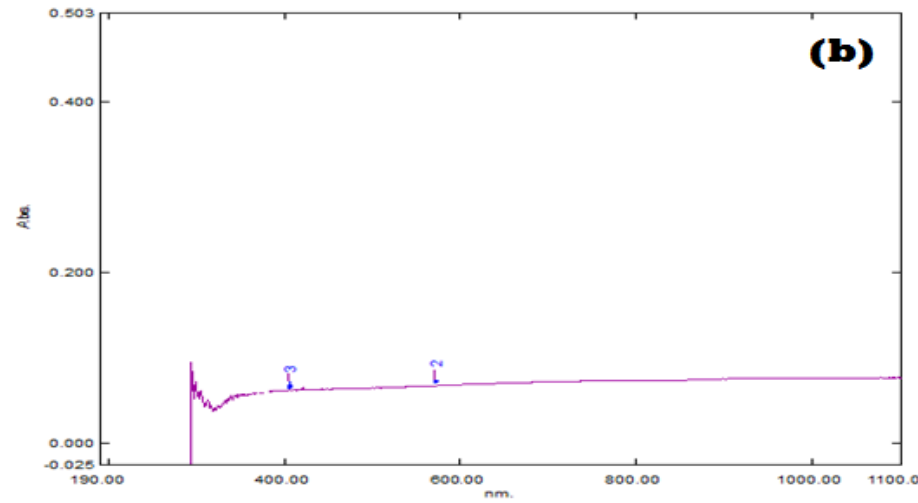
Fig.5: The UV ــ VIS absorption spectra of M-WCNTs DI water suspension at volume fraction 13 x10 -5 .